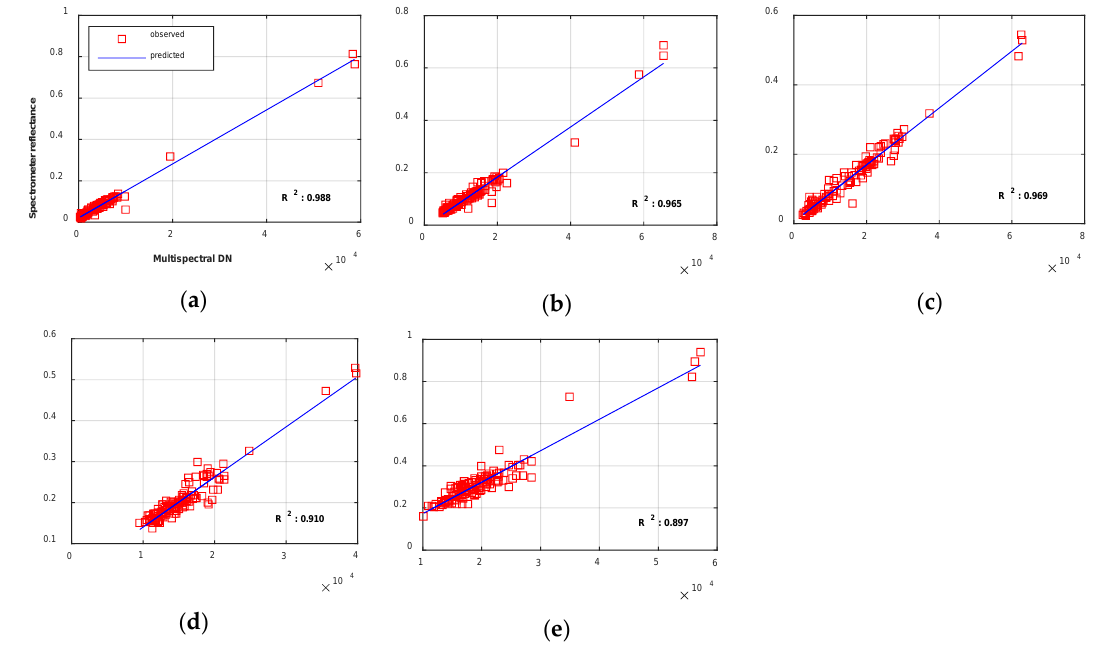
Figure 5. Per band multispectral camera-spectrometer regression for the optimal time alignment at Site 1 for spectral bands at 490 nm, 550 nm, 680 nm, 720 nm, and 800 nm ( a – e ), respectively. “DN” is digital number, the intensity units of the multispectral camera signal.